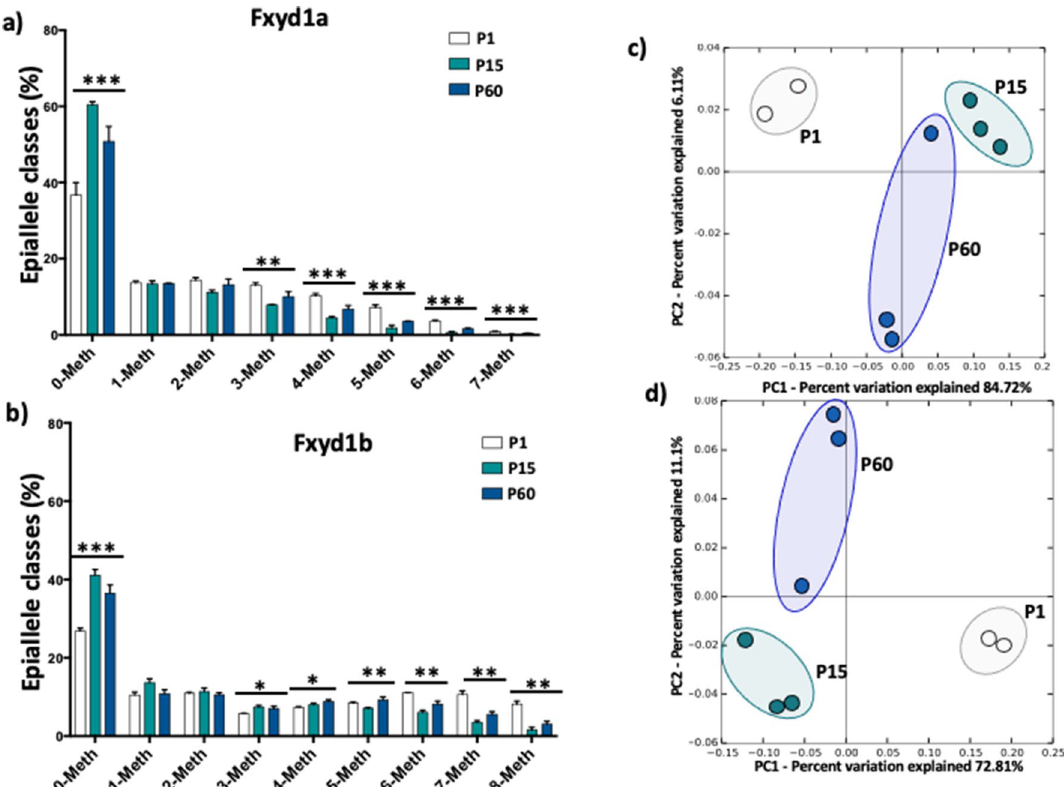
Figure 5. Epiallele classes and epiallele distribution analyses at the Fxyd1a and Fxyd1b in the heart. ( a ) Epiallele classes distribution of Fxyd1a promoter. The percentage of each epiallele class is shown for all analyzed developmental stages. Epiallele classes amount at each developmental stage was obtained by the sum of all epialleles carrying the same number of methylated CpG sites, regardless the position. Comparison between developmental stages was performed using One-way ANOVA. ( b ) Epiallele classes distribution of Fxyd1b promoter. Epiallele classes percentage is shown for all developmental stages. Epiallele classes amount at each developmental stage was obtained by the sum of all epialleles carrying the same number of methylated CpG sites, regardless the position. Comparison between developmental stages was performed using One-way ANOVA ( c ) Principal Component Analysis (PCA) plot showing epialleles distribution at Fxyd1a in brain at all the different developmental stages (white: post-natal day 1; green: post-natal day 15; blue: post-natal day 60). The analysis was based on all the possible epiallele combinations given by the number of analyzed CpGs (128 possible epialleles). PCA was performed by running the beta_diversity_through_plots.py script from QIIME. The Principal Components 1 and 2, ranked according to the fraction of between sample variance explained, are used to plot the samples in the bidimensional space. The two components capture more than 50% of the variance of the data. ( d ) PCA plot showing epialleles distribution at Fxyd1b in brain between the different developmental stages (white: post-natal day 1; green: post-natal day 15; blue: post-natal day 60). The analysis was based on all the possible epiallele combinations given by the number of analyzed CpGs (256 possible epialleles). PCA was performed by running the beta_diversity_through_plots.py script from QIIME. The Principal Components 1 and 2, ranked according to the fraction of between sample variance explained, are used to plot the samples in the bidimensional space. The two components capture more than 50% of the variance of the data.*p < 0.05; **p < 0.01; ***p <